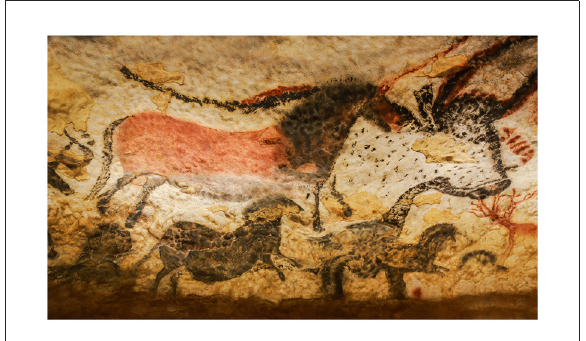
FIGURE1 Cave drawing from Lascaux II paintings, Lascaux, France.